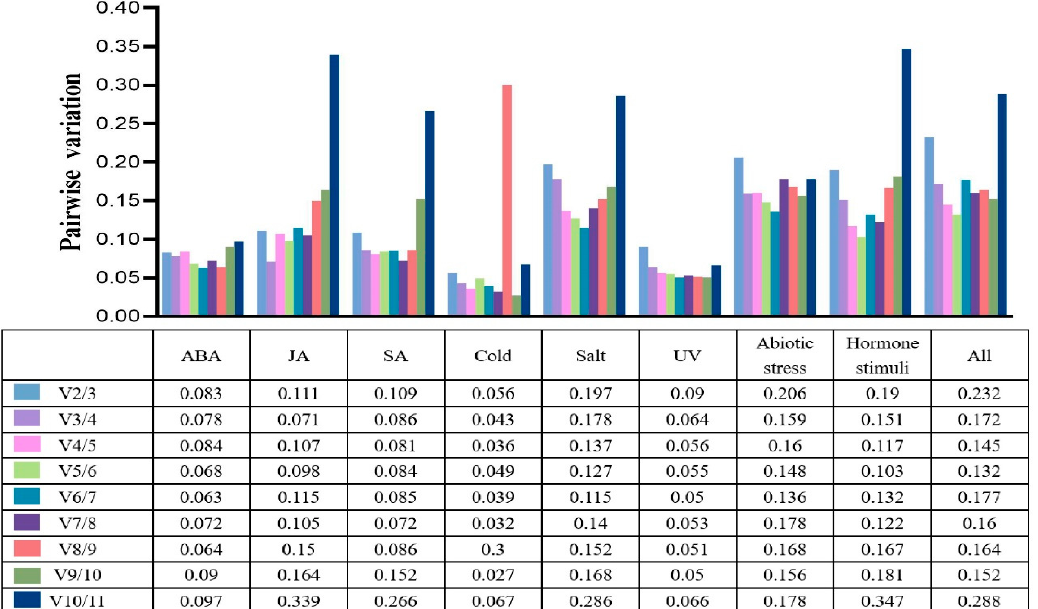
Figure 2. The suitable number of reference genes for normalization in Saussurea laniceps. The upper histogram has a corresponding relationship with the data in the lower table; each color bar represents a V n/n+1 value.